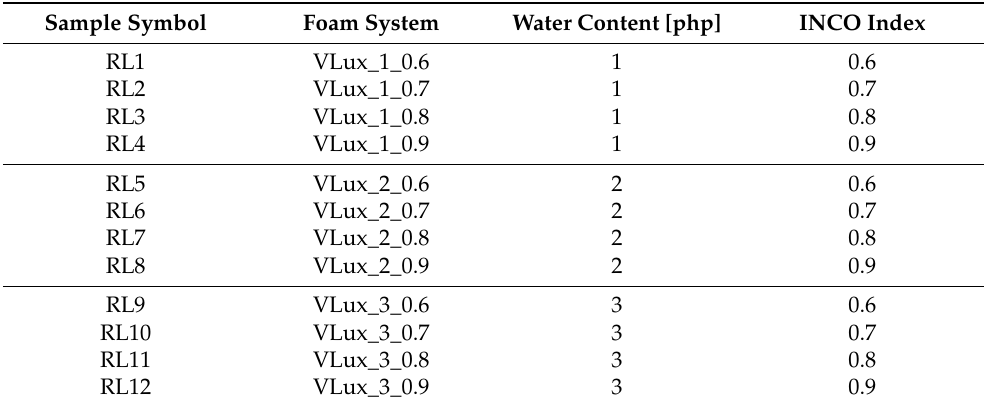
Table 2. Characteristics of manufactured polyurethane